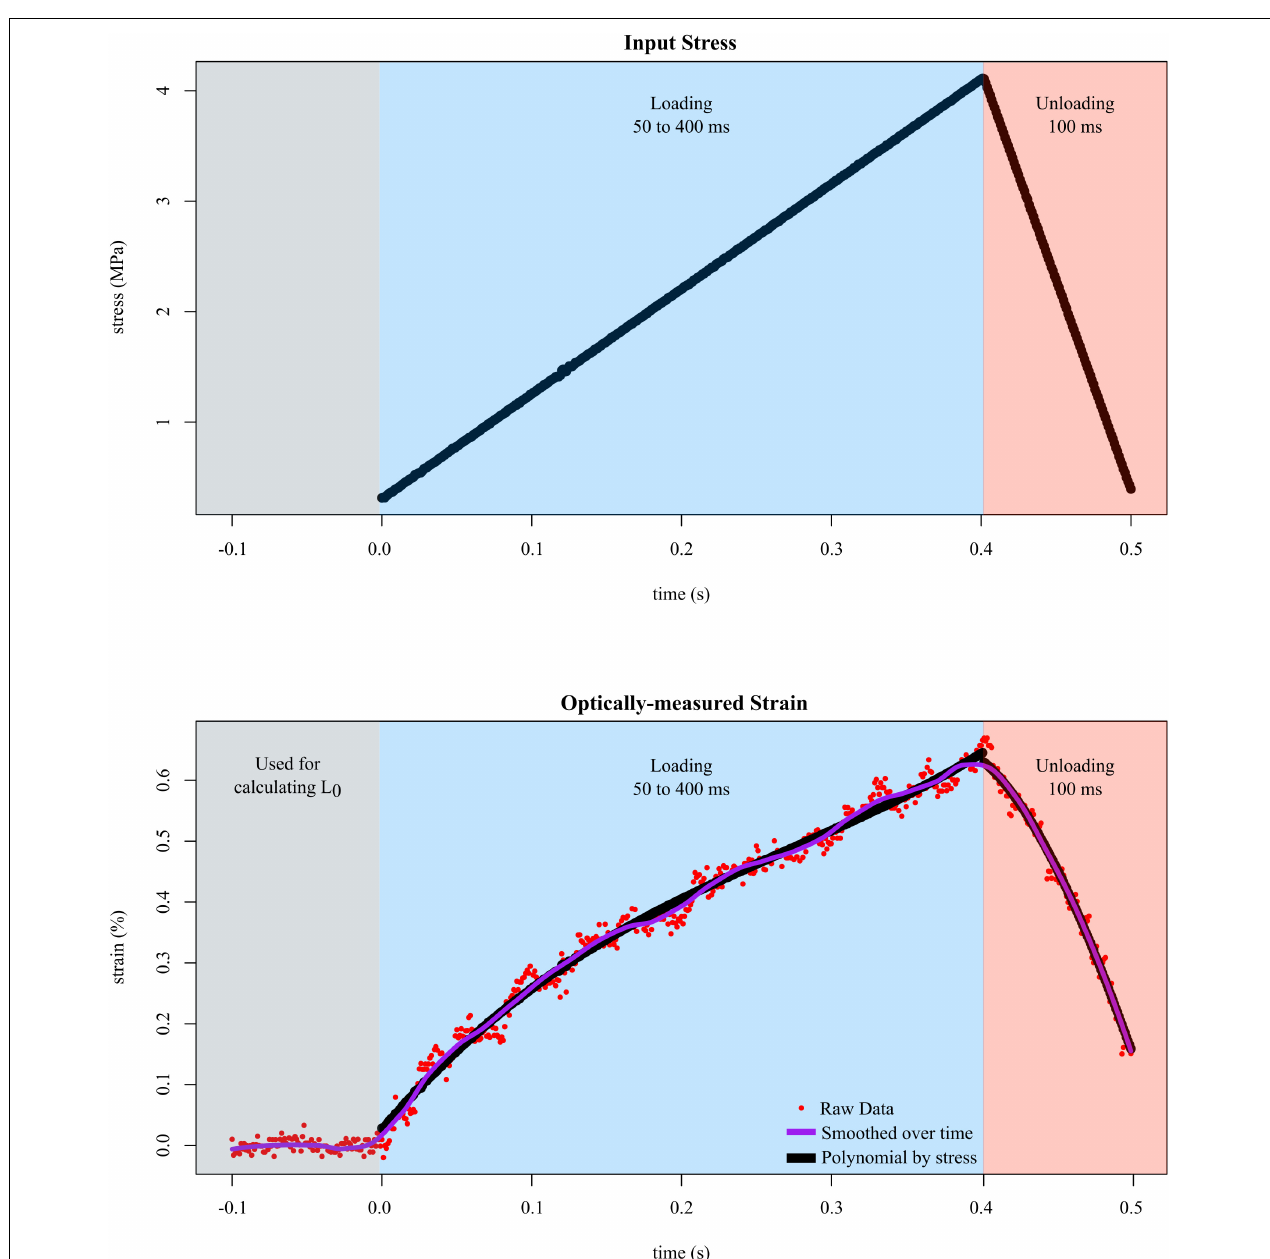
FIGURE 3 | Tendon fascicles were linearly loaded to ∼ 4 MPa of stress at different rates while strain was optically-measured. To determine the mechanical response to stress rate, the duration of loading (blue background) was experimentally varied between 50 and 400 ms. After loading, the tendon fascicle was unloaded to its original stress within 100 ms in preparation for the next trial (red background) . Calculating strain required dividing length by L 0 , which was defined as the average distance between the markers over 100 ms prior to input stress (gray background) . The raw strain data (red dots) , were then smoothed via LOESS over time. The final phase of smoothing involved fitting 3rd order polynomials (black lines) to the stress-strain data of the loading